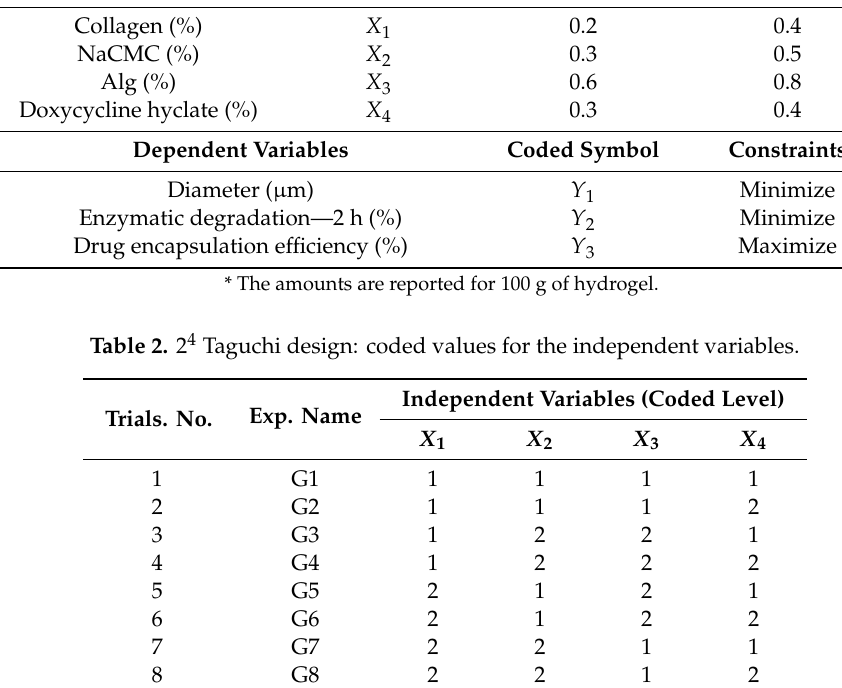
Table 1. Process variables and experimental conditions in the 2 4 Taguchi design. Independent Variables *